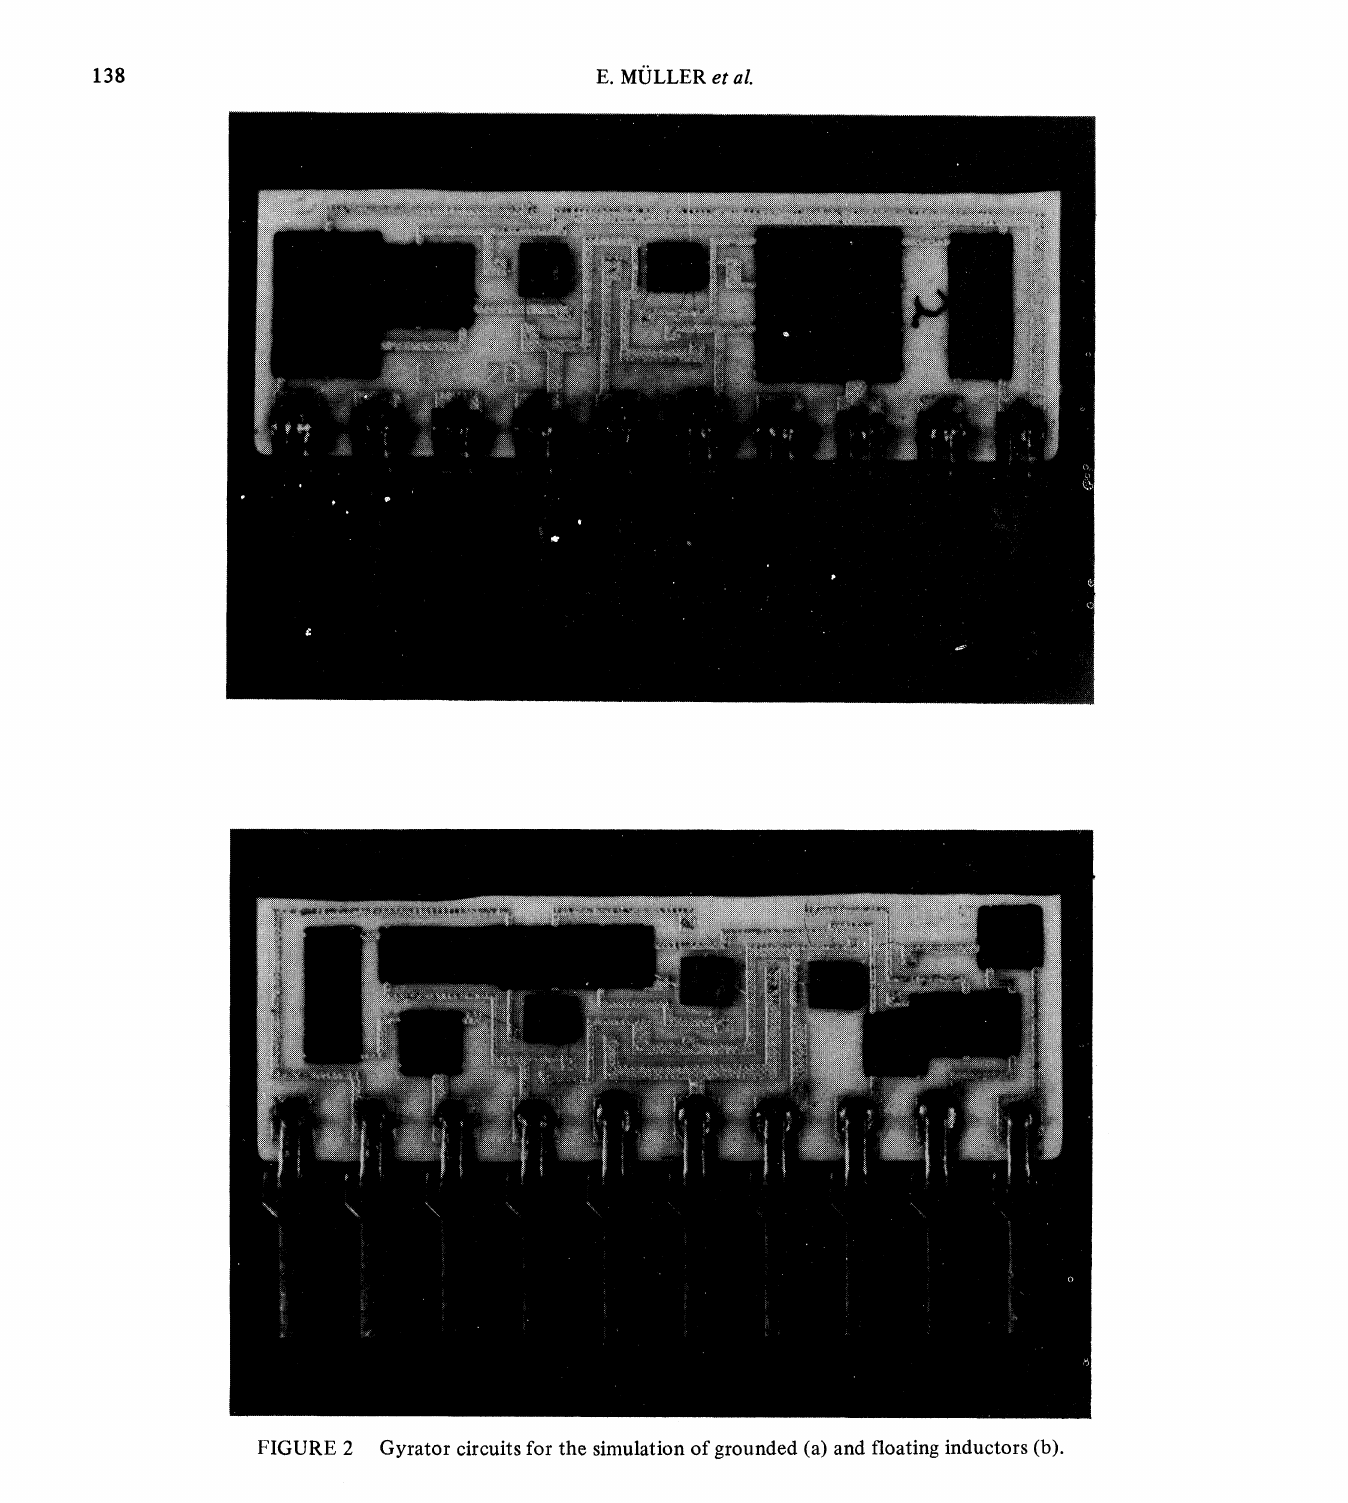
FIGURE 2 Gyrator circuits for the simulation of grounded (a) and floating inductors